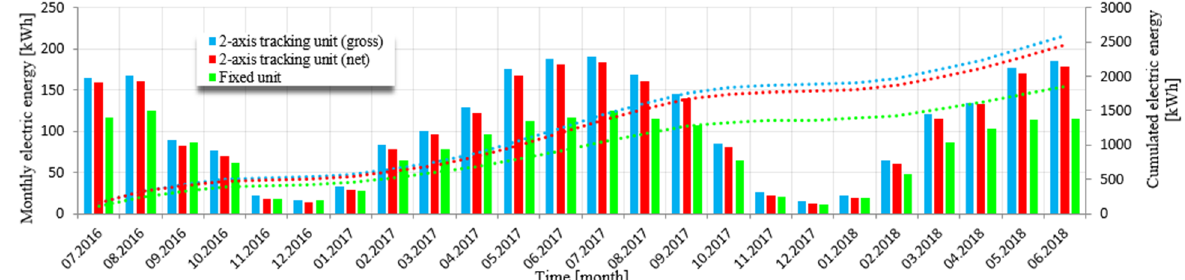
Figure 11. Variability of electricity produced by photovoltaic modules in the fixed and dual-axis tracking configurations for a two-year measuring period and accumulated value, taking into account the consumption for the purpose of supplying actuators.